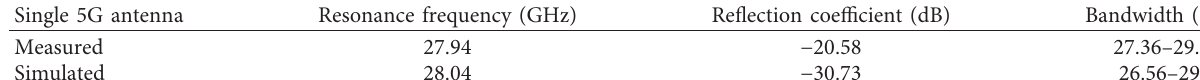
Figure 10: Simulated and measured reflection coefficients of the proposed single antenna. Table 2: Simulated and measured S 11 and bandwidth of the single antenna.